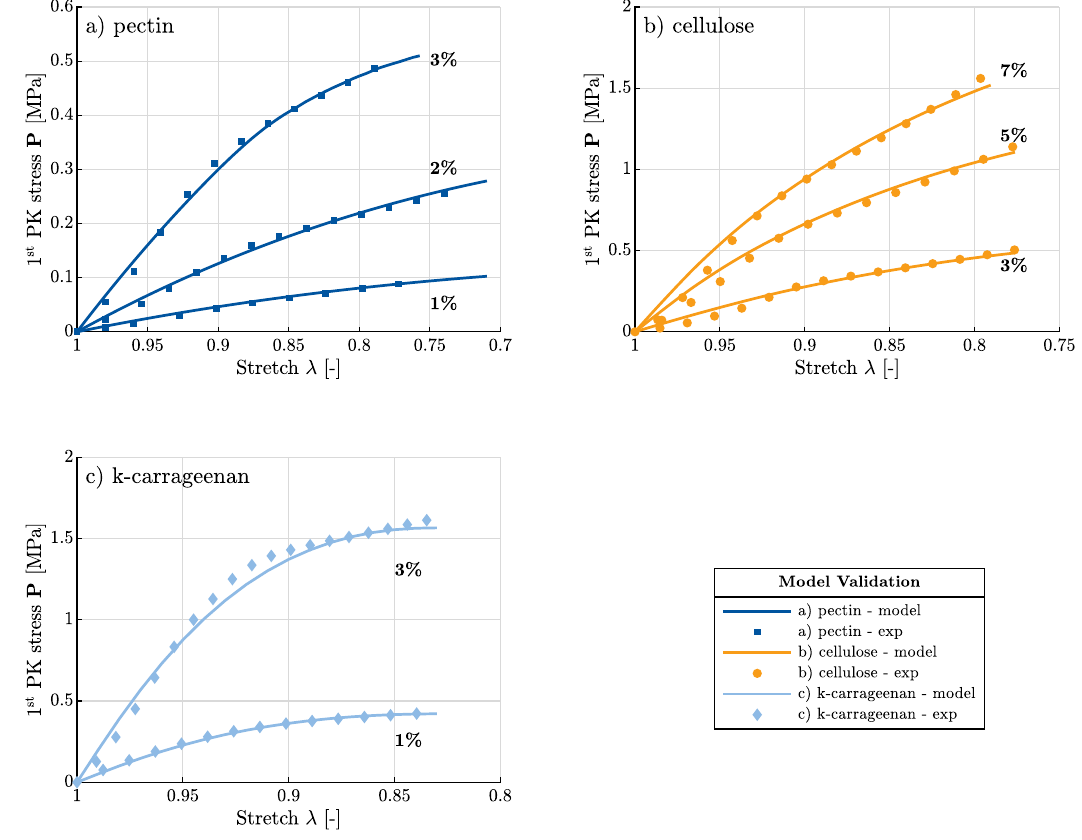
Figure 9. Model predictions versus experimental data for three polysaccharide-based aerogels: ( a ) pectin, ( b ) cellulose and ( c )